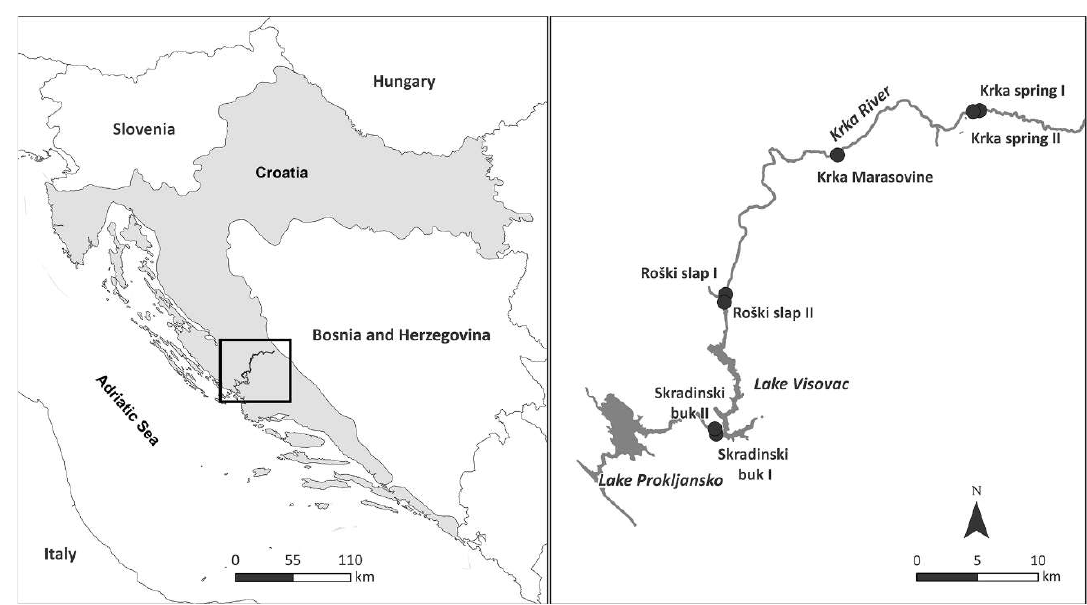
Figure 1. Map of the four sampling locations (Krka spring, Marasovine, Roški slap and Skradinski buk) situated at the Krka river, Croatia (Krka spring, Roški slap and Skradinski buk were sampled on two representative habitats—marked with “I” and “II”).